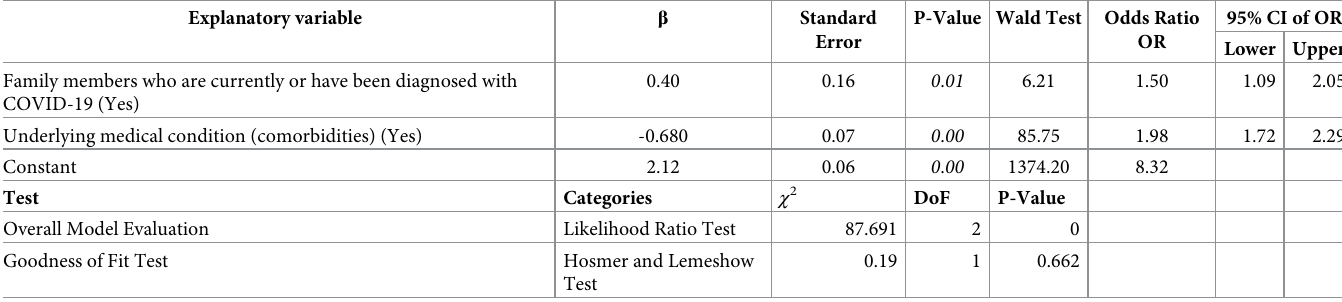
Table 4. Regression analysis—predictors of extended demography variables and COVID-19 vaccine intentions. Explanatory variable Family members who are currently or have been diagnosed with COVID-19